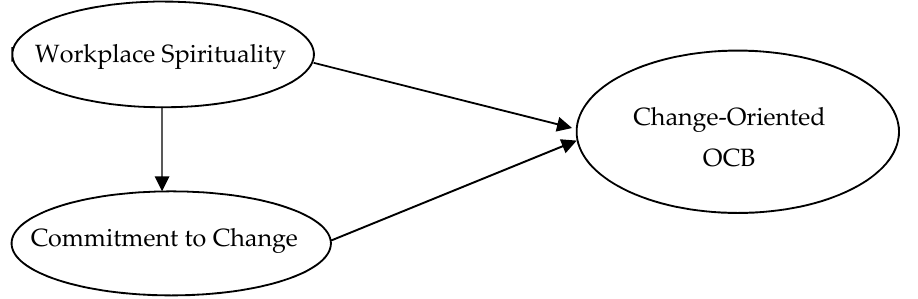
Figure 1. The relationship between concepts.